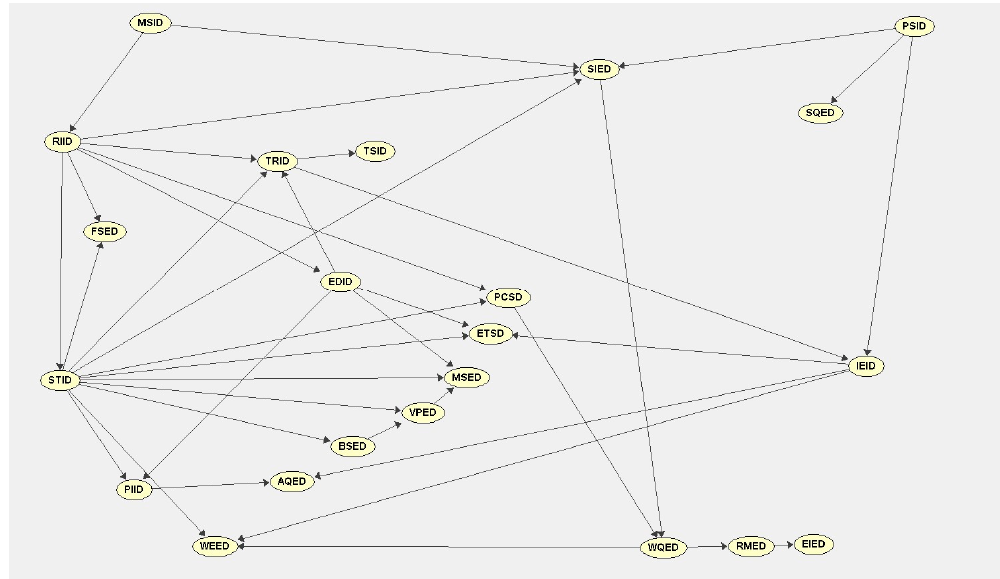
Figure 3. Bayesian Network.